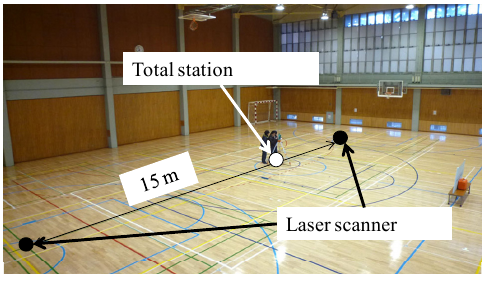
Figure 8. Sensor arrangement